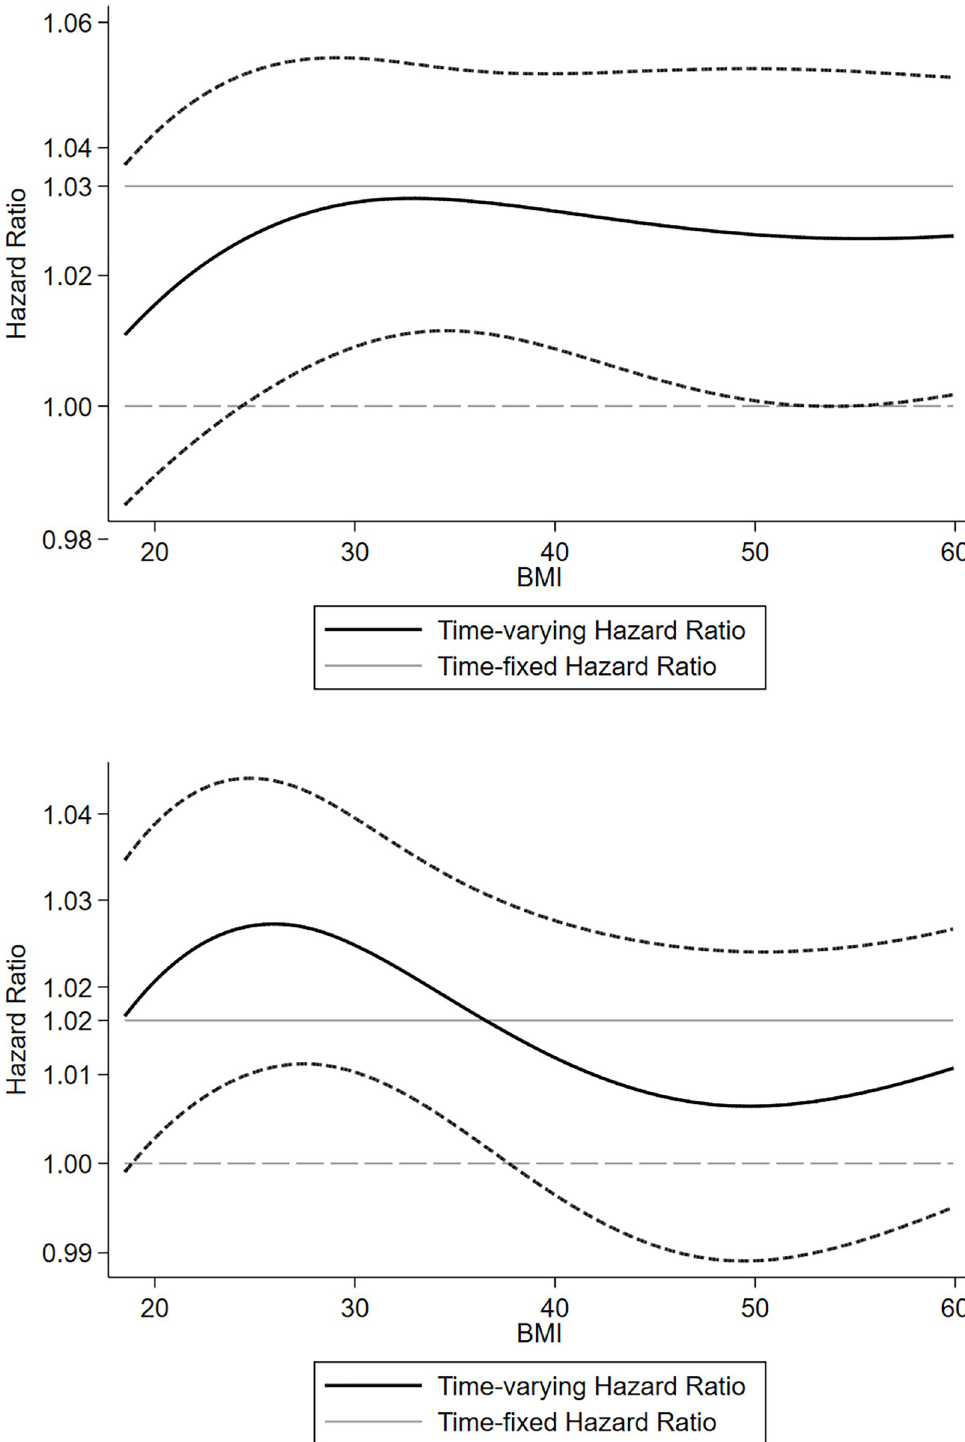
Fig 5. Time varying hazard ratio of BMI and (a) all-cause mortality and (b) major adverse cardio-cerebrovascular events (MACCEs).